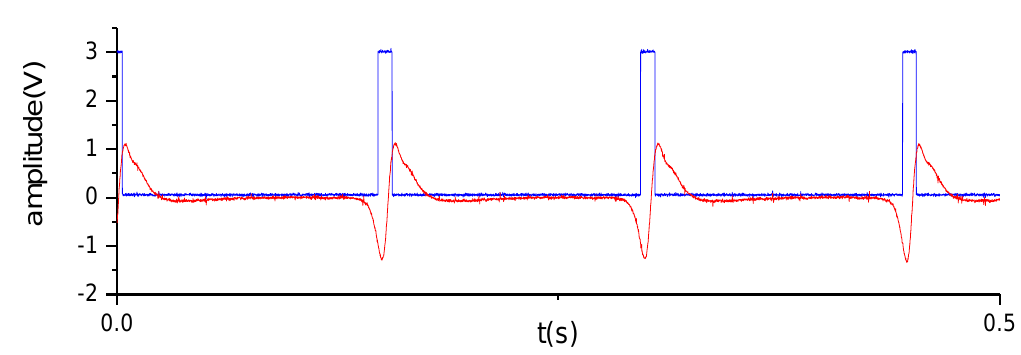
Figure 16. Input ( a ) and output ( b ) of the filtering circuit.